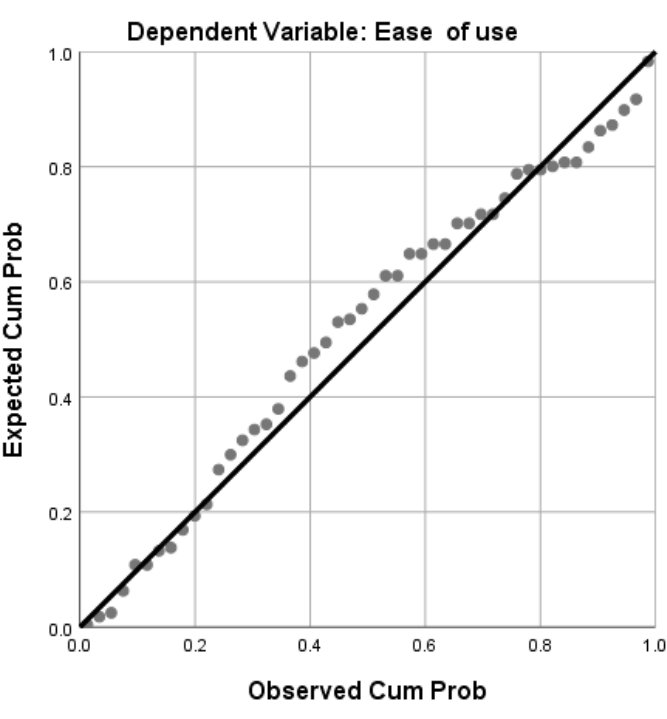
Figure 2. Normal P-P plot of regression standardized